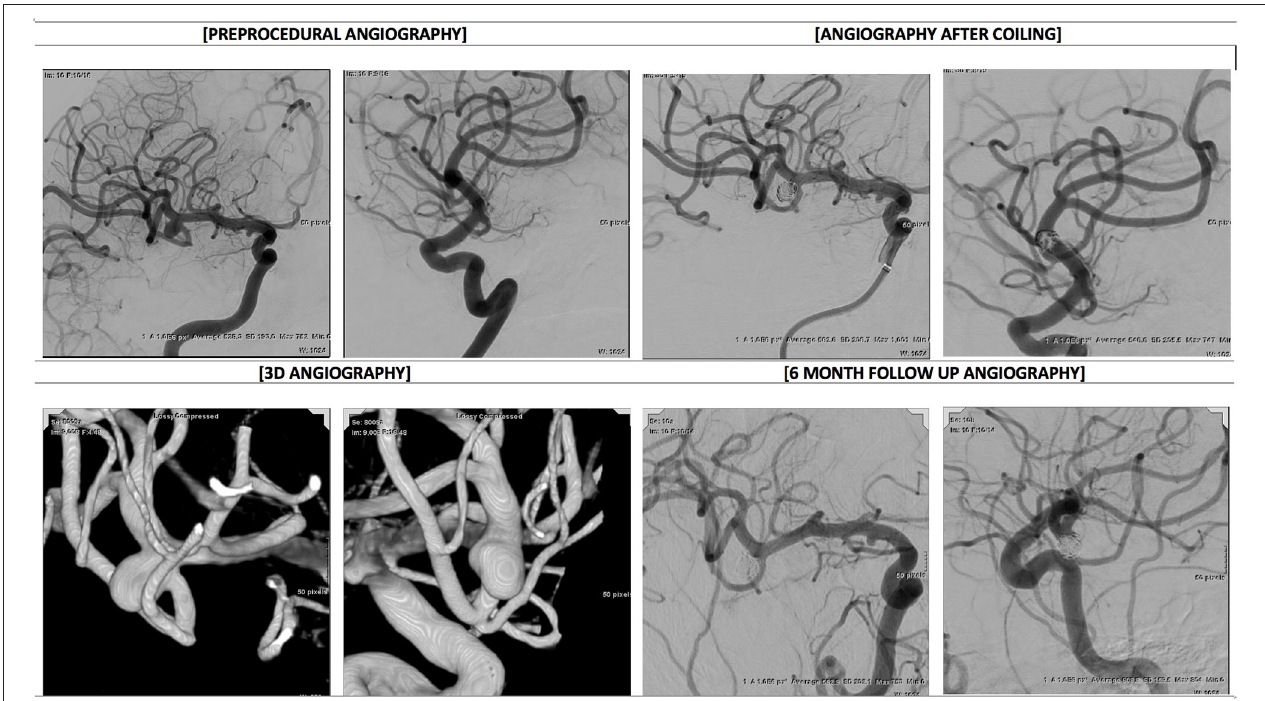
FIGURE 1 | Angiography before and after coiling − 53 y.o. male patient presents with unruptured 6mm right MCA bifurcation aneurysm. Baseline and immediately post stent assisted coiling DSA images in working projections, baseline 3D images in orthogonal projections and final DSA images available at 6 months follow up shows Raymond Roy 2 occlusion with small residual dog ear best depicted on lateral oblique projection (bottom right panel).